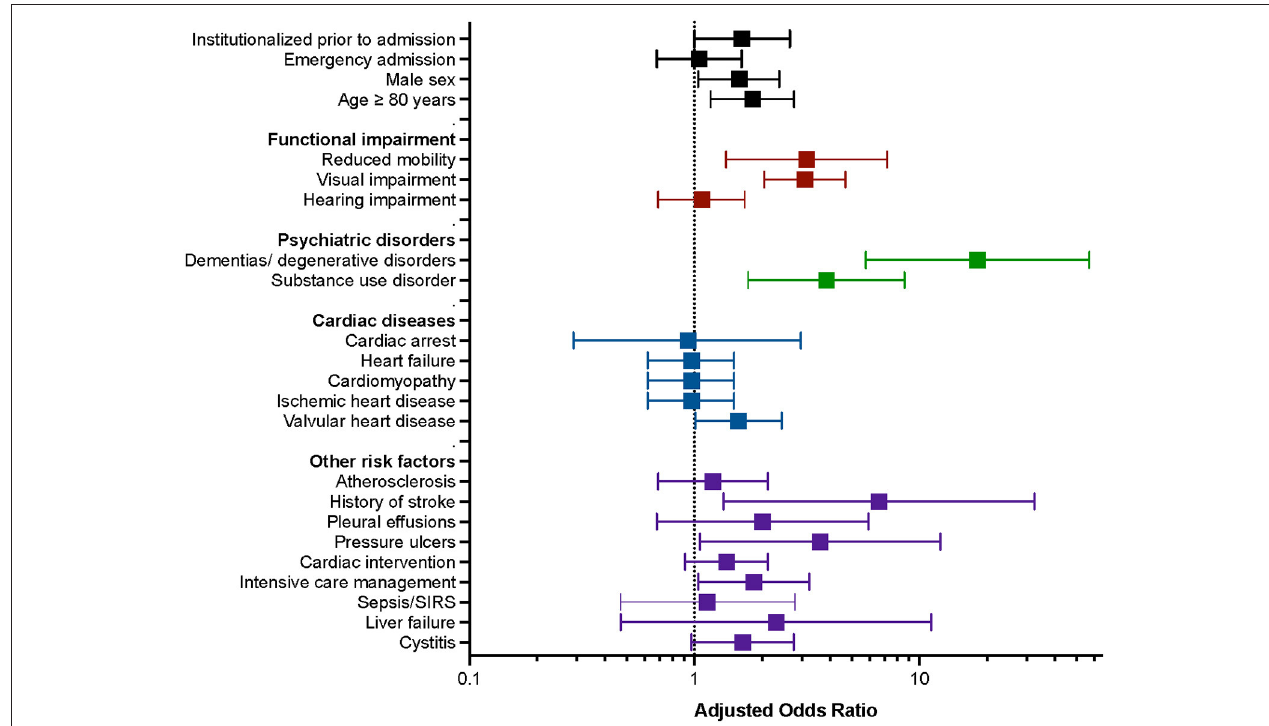
FIGURE 2 | Graphic representation of the multiple regression model of predisposing and precipitating factors for the development of delirium in patients admitted at the cardiology ward. Predisposing and precipitating factors are grouped by demographic factors, functional impairment, psychiatric disorders, cardiac diseases, and other risk factors (y-axis). Adjusted odds ratios and 95% confidence intervals are shown for each factor (x-axis).